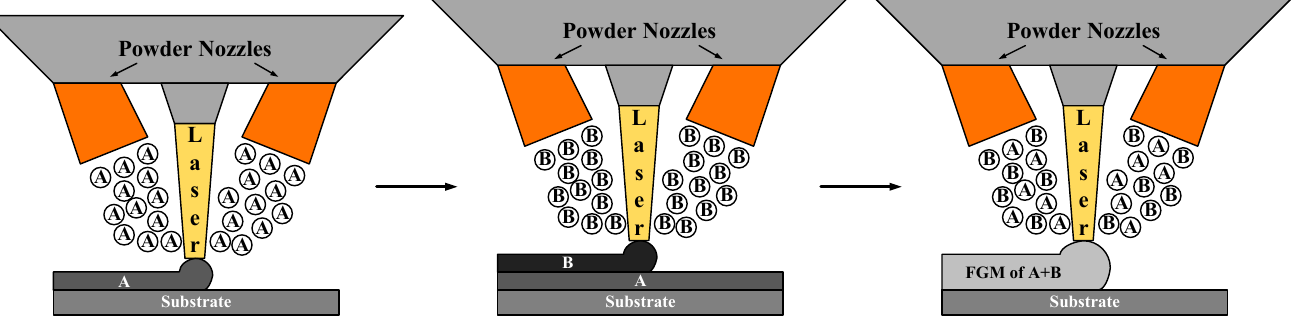
Figure 1. Principles of functional gradient functional material forming by coaxial powder feeding/laser fusion deposition Figure 1. technology.